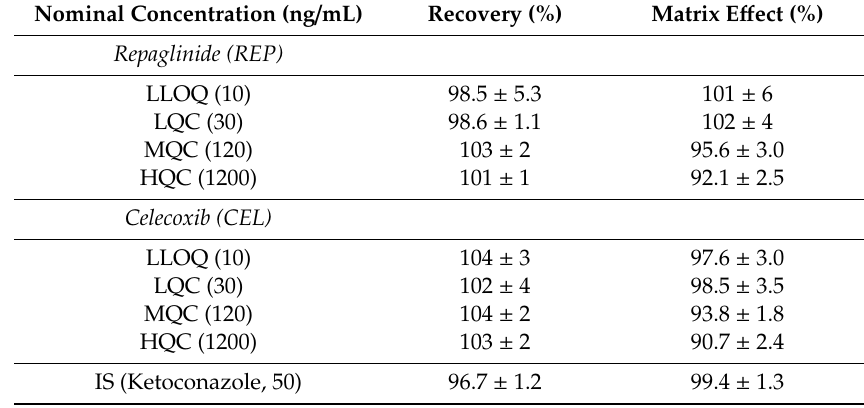
Table 2. Recovery and matrix e ff ect of REP, CEL, and IS in rat plasma ( n = 5).